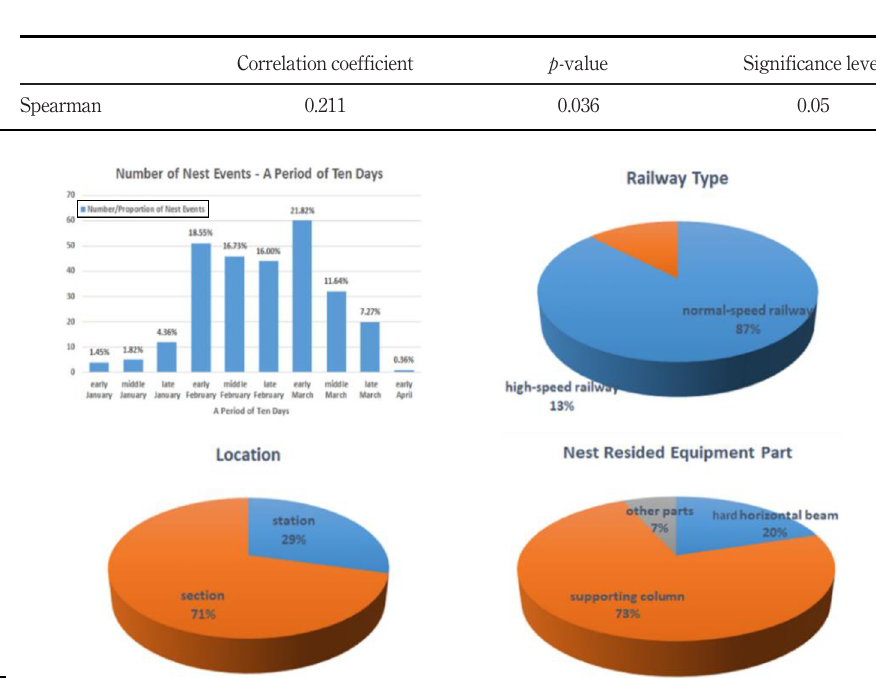
Figure 7. The nest events Spatio-temporal distribution